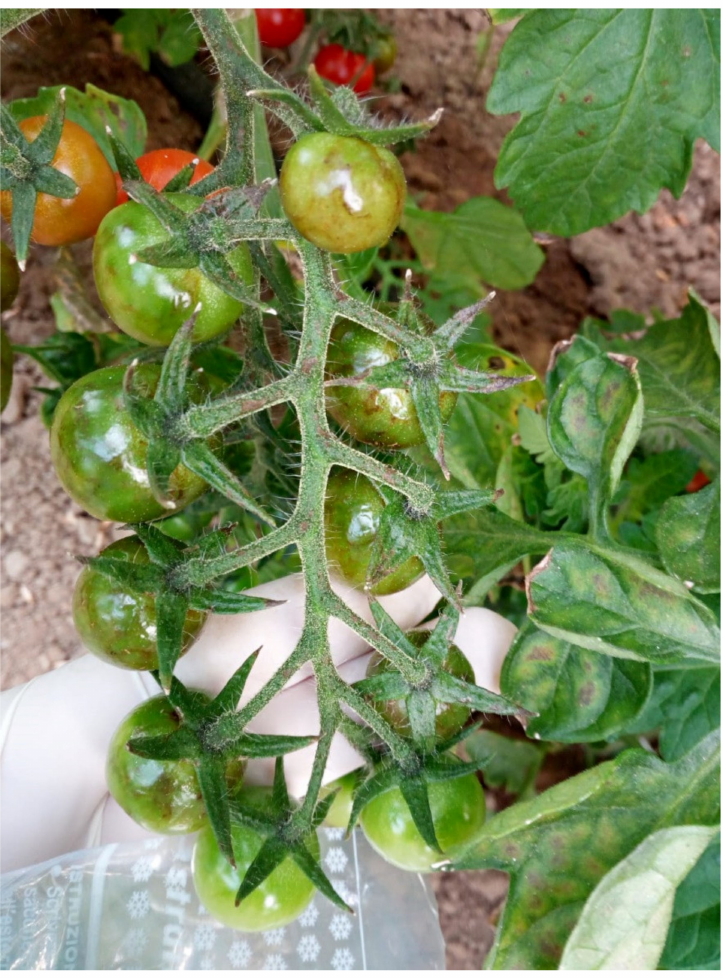
Figure 15. Typical corky rings on tomato fruits induced by Parietaria mottle